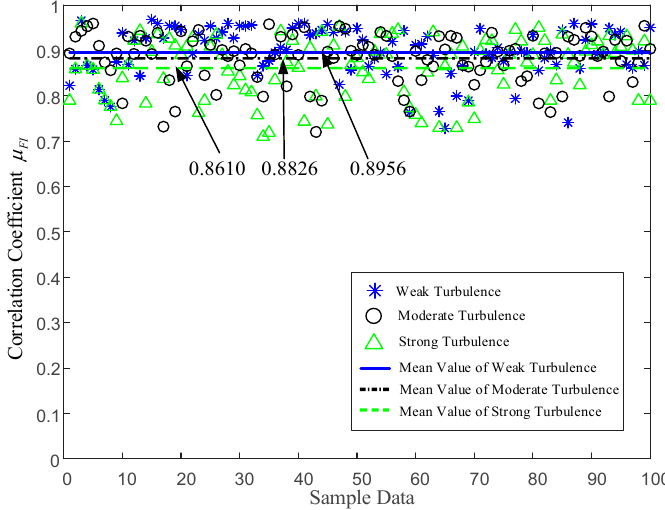
Figure 7. Correlation coefficient distribution and its average value.